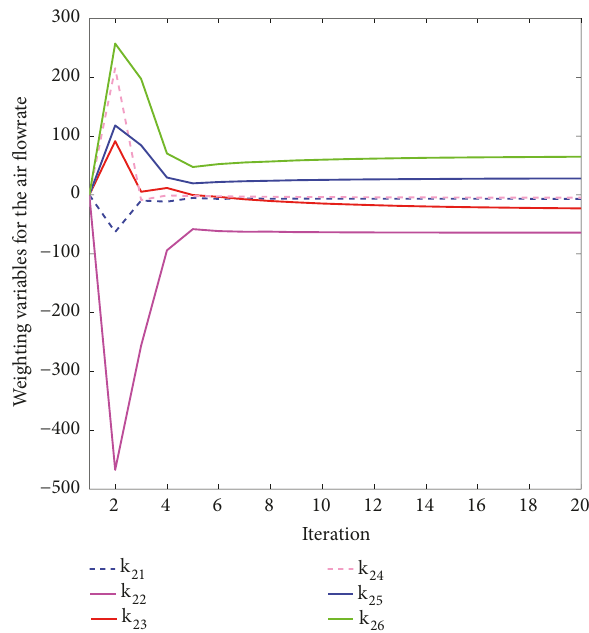
Figure 25: Iteration of the weighting variables for air flow rate in Task